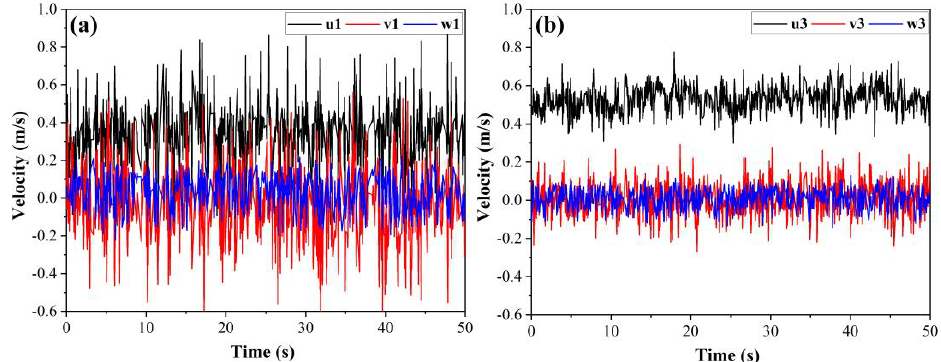
Figure 14. Temporal evolution of the flow velocity for HG1 and HG3 geometries at Location E, respectively, determined by the water channel experiment ( a ) for HG1 and ( b ) for HG3.